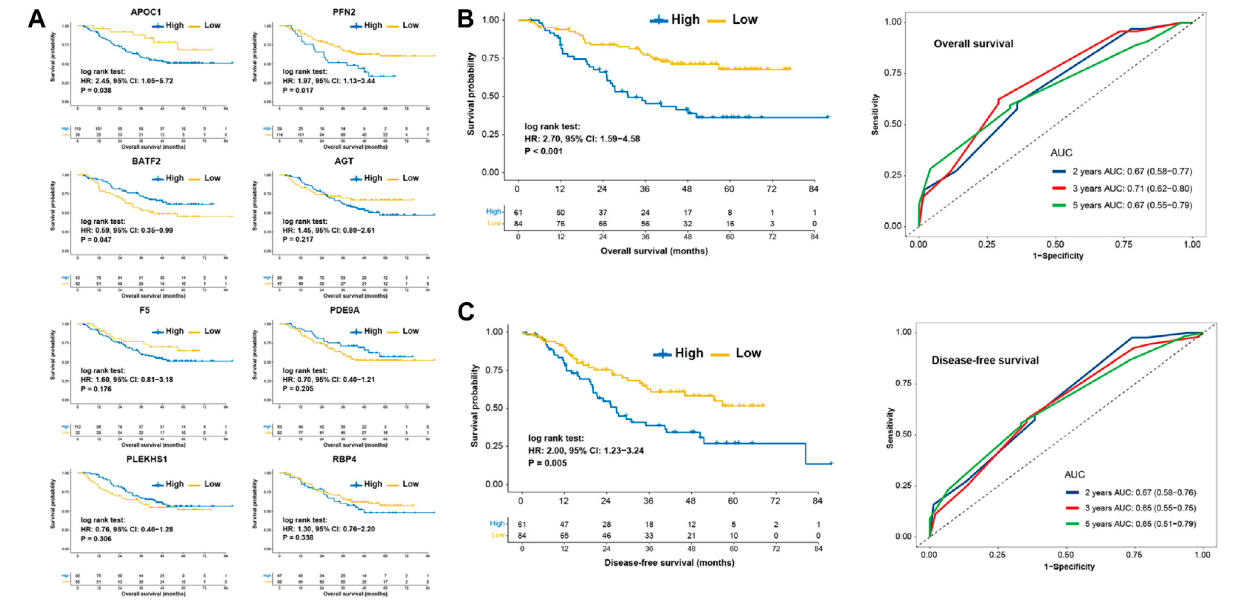
Frontiers in Cell and Developmental Biology |